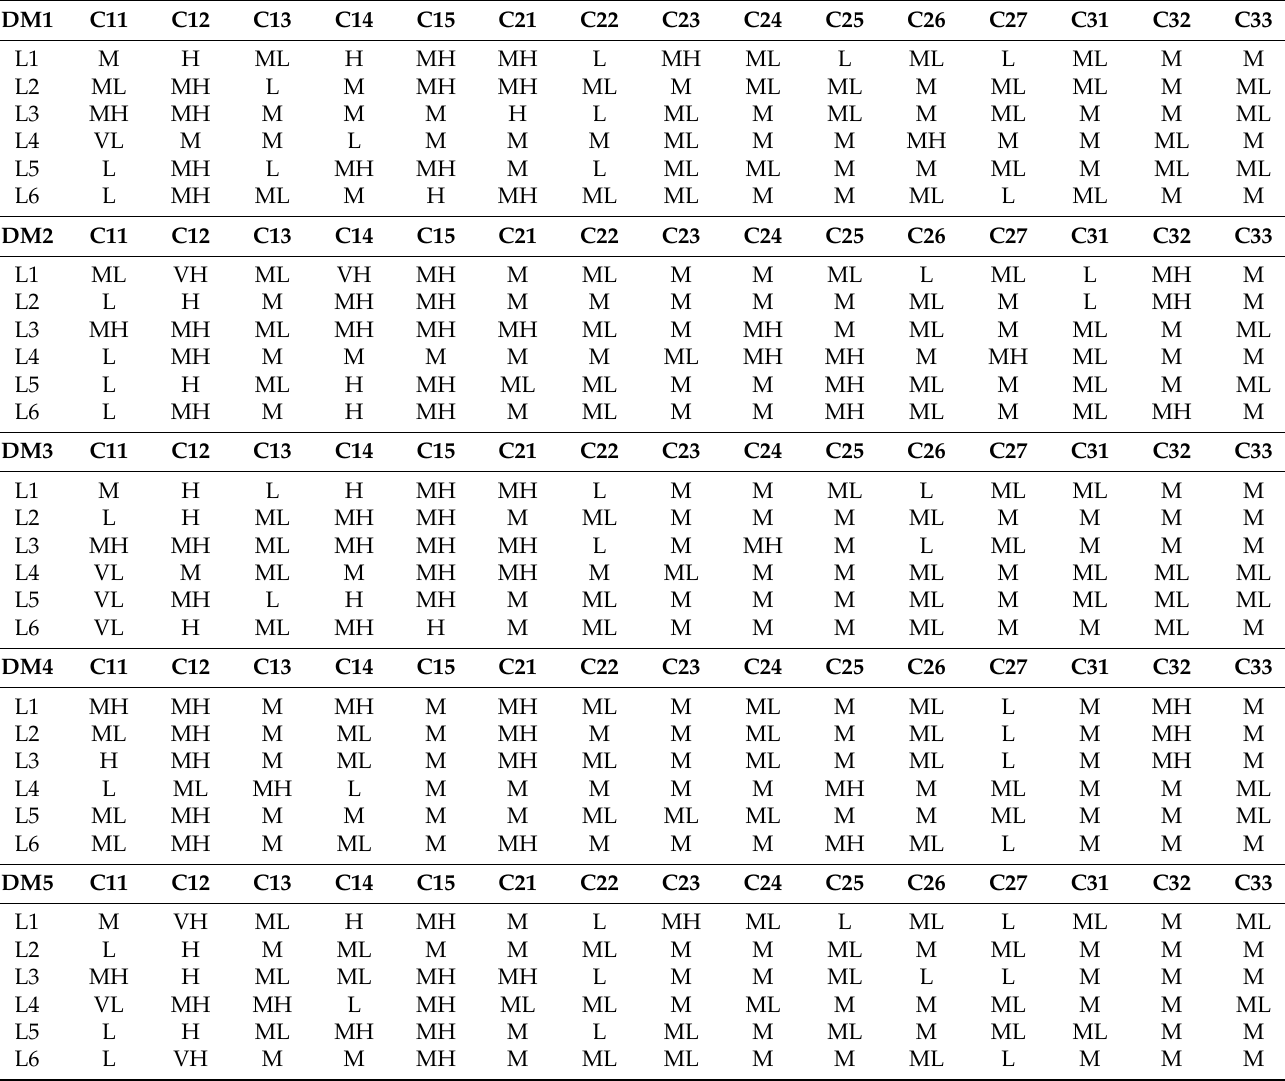
Table 7. Linguistic evaluations of research